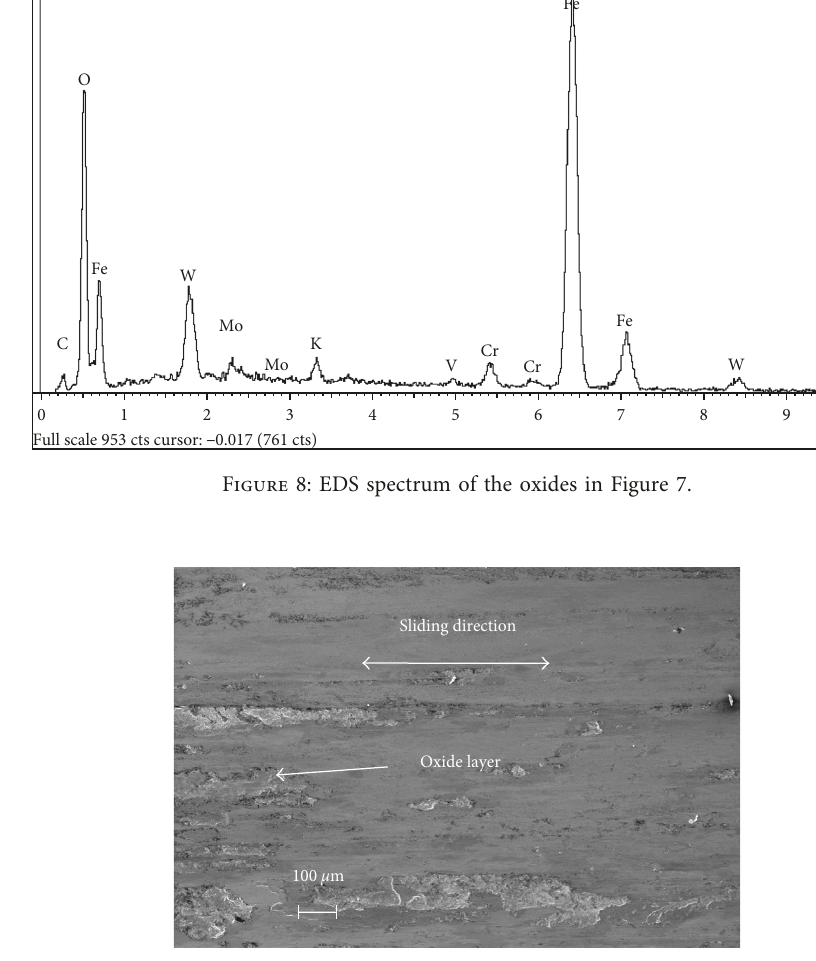
Figure 9: Scanning electron microscope micrograph of the steel 3 disk surface tested at 40 ° C.